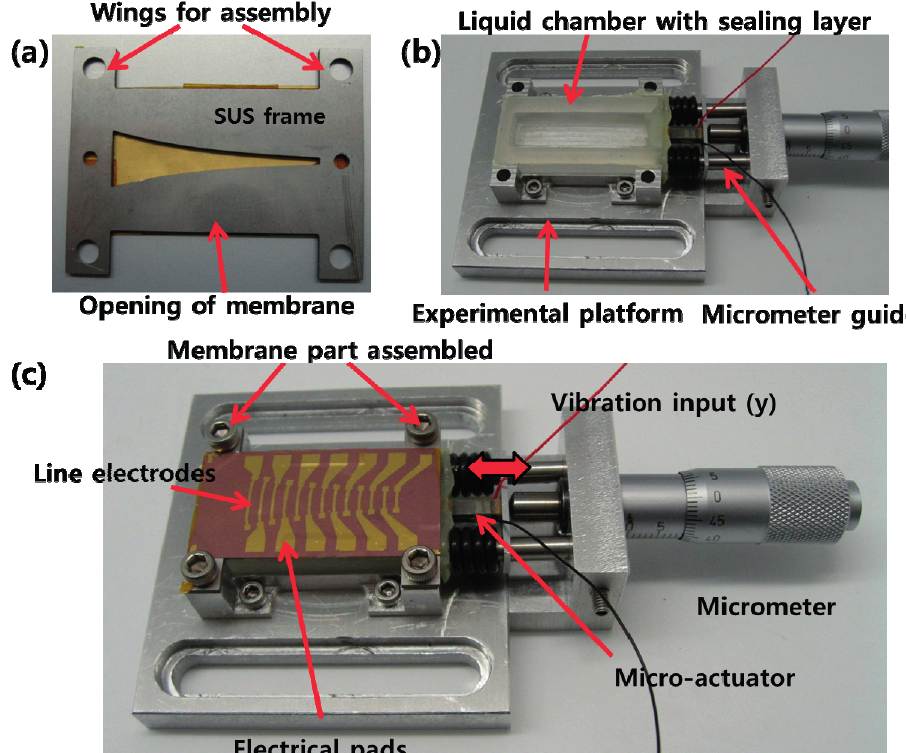
Figure 7. Photographs of bottom side of membrane part ( a ); packaged part ( b ); assembled PAC with liquid chamber on the experimental platform ( c